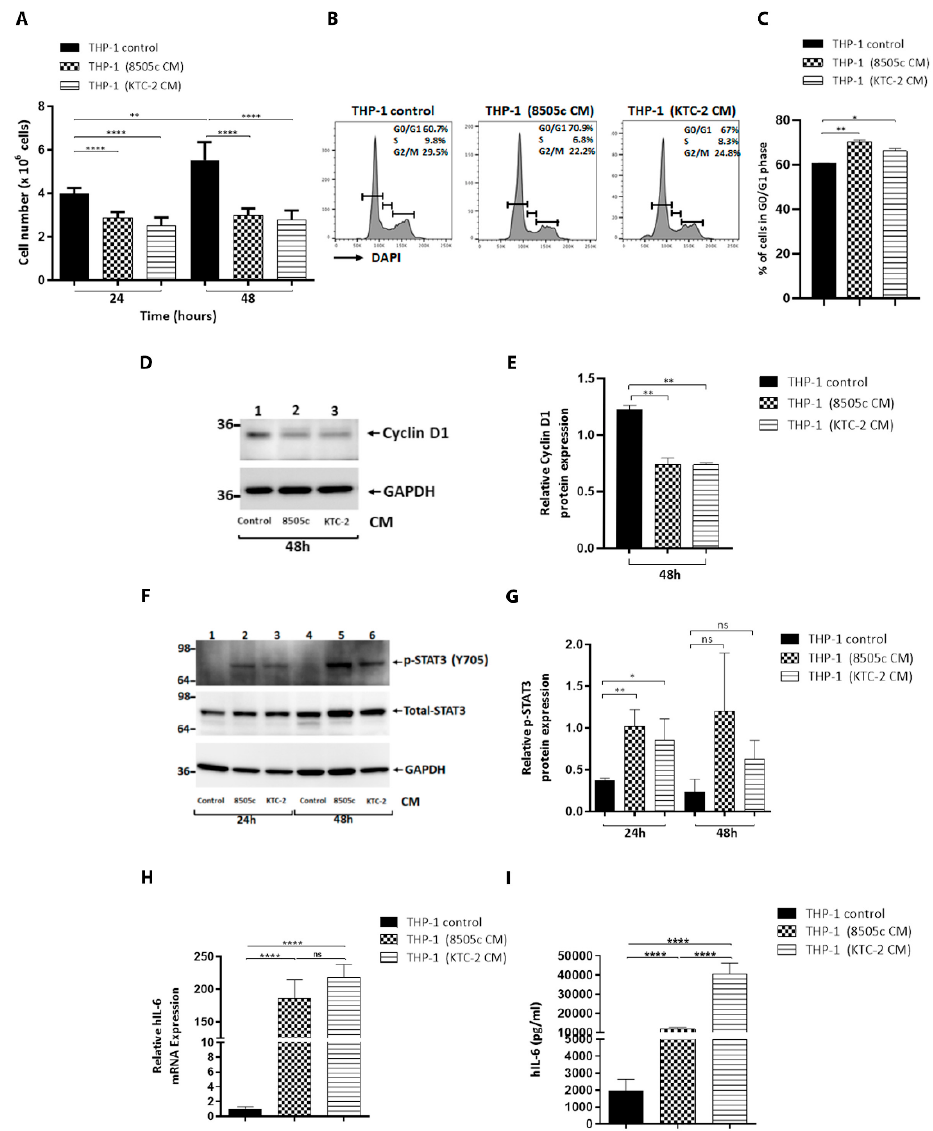
Figure 2. ATC cell-derived CM decreased proliferation of human monocytes. ( A ) Proliferation of THP-1 cells incubated with complete media containing 5% FBS (THP-1 control) or 100% 8505c-derived CM and 100% KTC-2-derived CM for 24 h or 48 h, estimated by cell counting. ( B ) Cell cycle profiles of THP-1 cells incubated with complete media containing 5% FBS (THP-1 control) or treated for 24 h with ATC cell-derived CM by flow cytometry analysis. The average percentages of cell populations of different cell cycle phases are shown in the upper-right corner. ( C ) The graphs showed the percentage of the G0/G1 phase for control and treatment with ATC cell-derived CM in THP-1 cells. The cell cycle phase was quantified by DAPI staining, followed by FACS analysis in THP-1 cells. ( D , E ) Immunoblot analysis of cyclin D1 in THP-1 cells grown under normal conditions (THP-1 control) or exposed for 48 h to CM derived from ATC cells ( D ). Quantification of relative expression of cyclin D1 protein in human monocytes after using GAPDH as loading control ( E ). Full Western Blot is shown in Figure S7. Human monocytes activated by ATC cell-derived CM promoted IL-6 levels via the induction of STAT3 phosphorylation ( F , I ). ( F ) Immunoblot for p-STAT3 from THP-1 cells incubated with complete media containing 5% FBS (THP-1 control) or treated with CM derived from ATC cells, 8505c and KTC-2, for 24 h and 48 h. The figure shows a representative Western blot of four independent experiments. The lower panel was the corresponding loading control using GAPDH. ( G ) Quantification of relative expression of p-STAT3/Total STAT3 proteins in human monocytes. The same blot was stripped and re-blotted using anti-Total STAT3 antibody. Uncropped Western Blot is shown in Figure S7. ( H ) Expression levels of IL-6. mRNA levels by RT- qPCR in control and THP-1 cells incubated with complete media containing 5% FBS (THP-1 control)